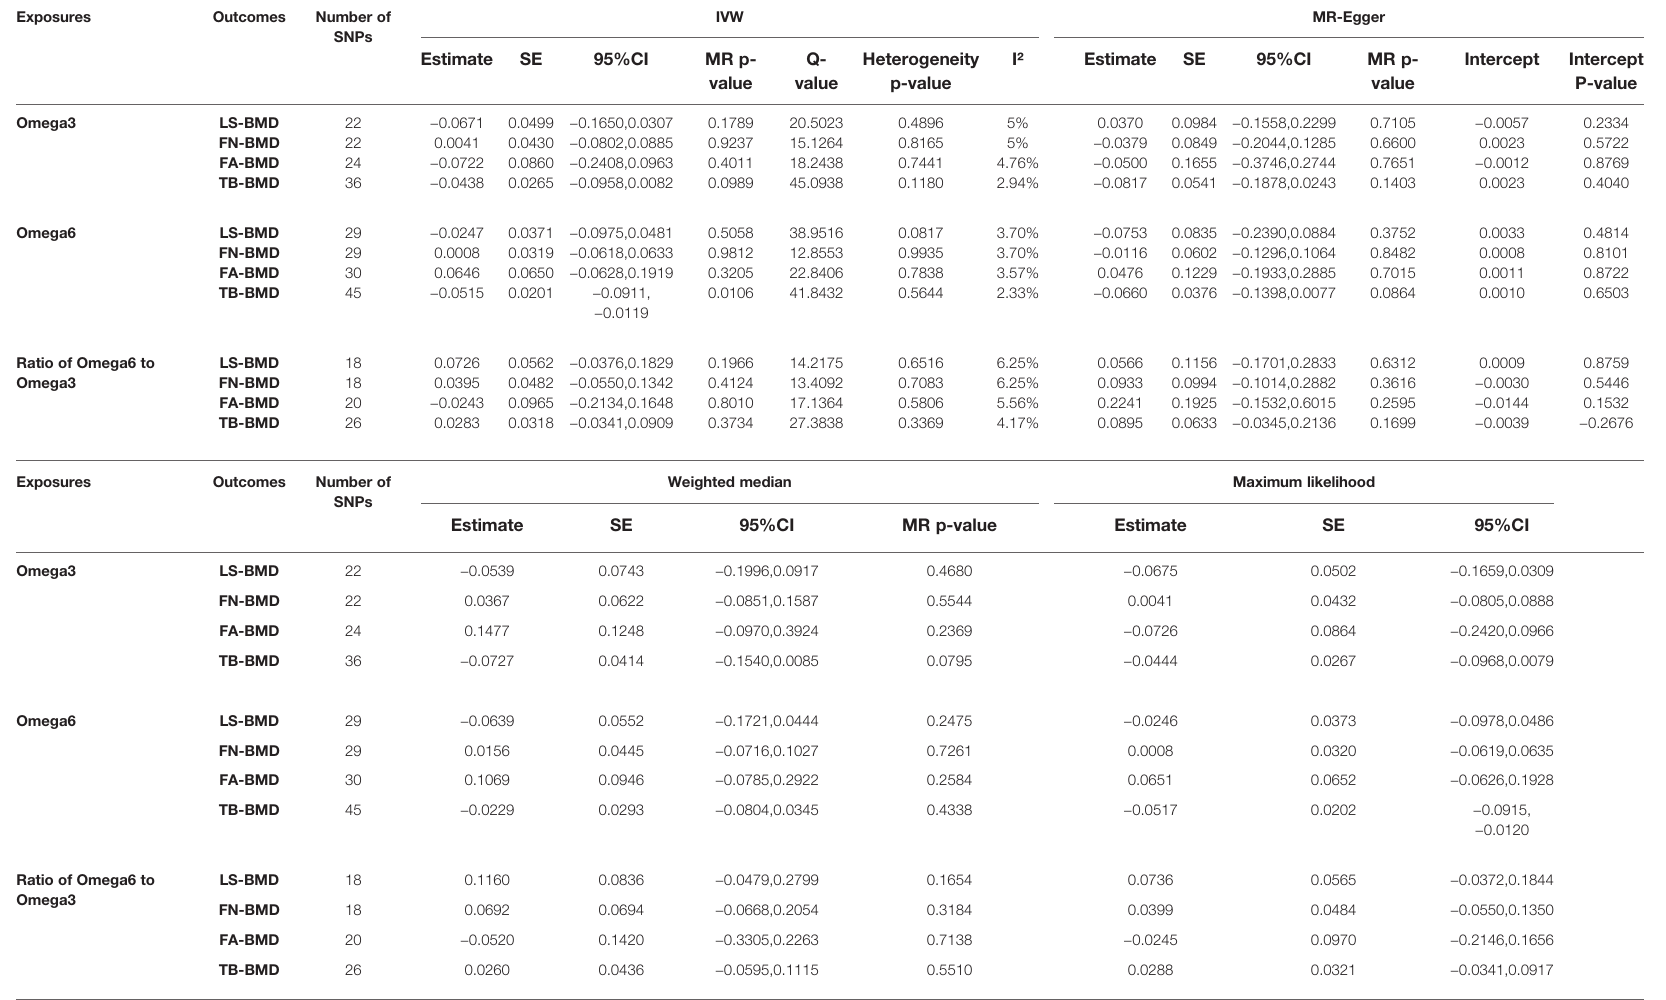
TABLE 1 | MR estimates of the causal effects of PUFAs on BMD using various analysis